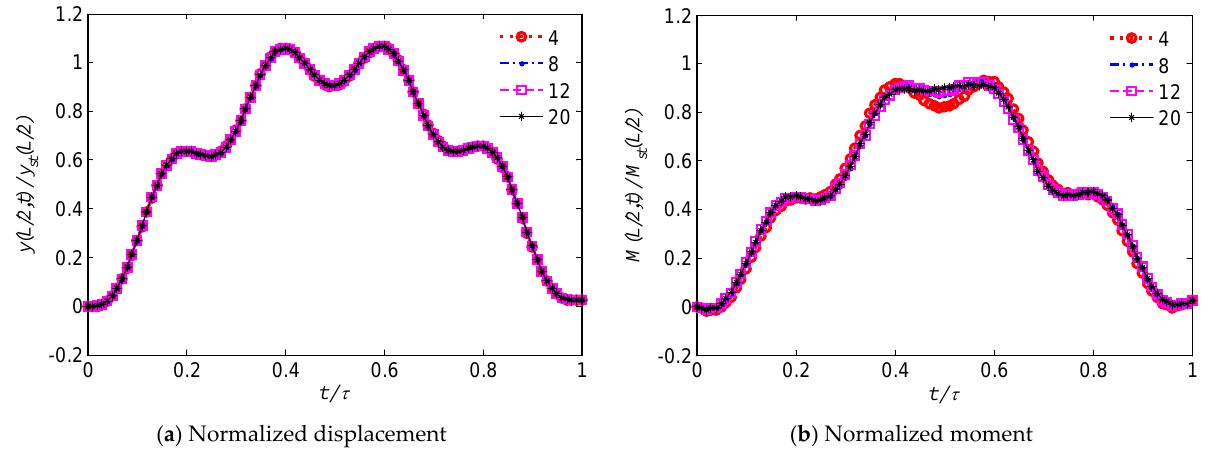
Figure 2. Different truncated series solutions of the beam with b = 0.03 and c = 0.11.